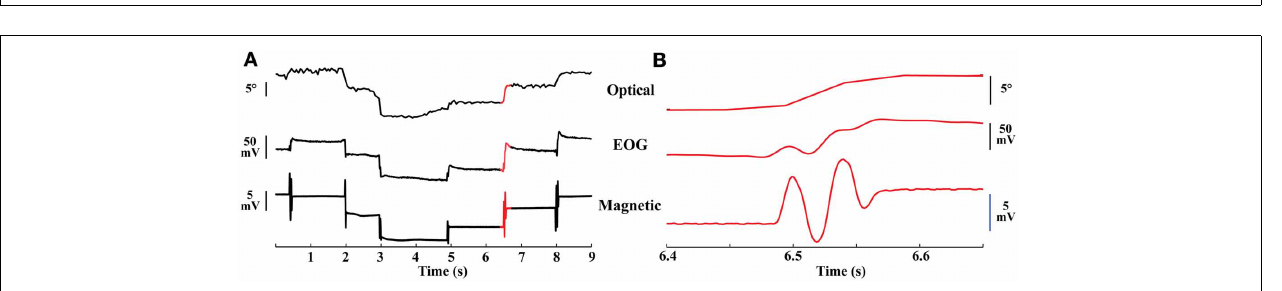
position. The range of eye motion was larger in the horizontal (B) than in the vertical (C) axis. Different colors represent different birds ( n = 3). Open symbols represent left eye positions and solid symbols represent right eye positions. The bin size is 1 ◦ . The red line is a Gaussian fit of the mean in each bin across birds. In these and all subsequent plots, negative values represent nasal or ventral eye positions in the horizontal or vertical dimensions, respectively.